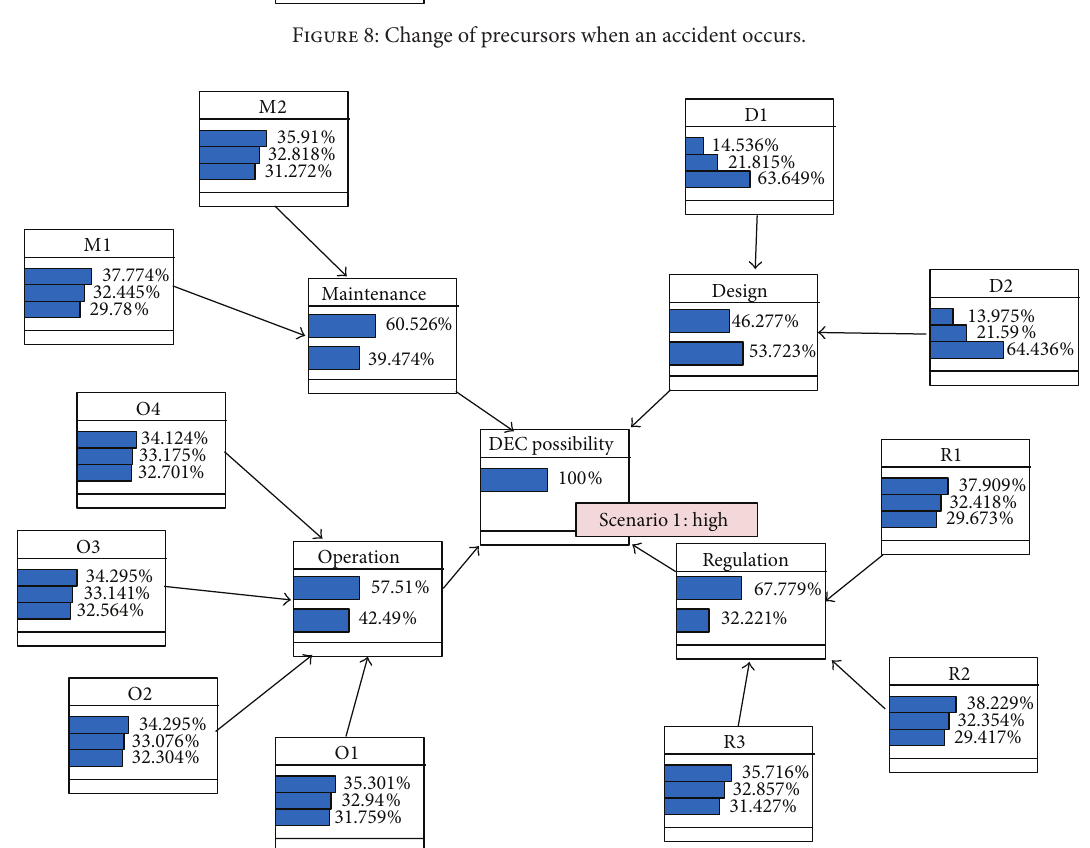
Figure 8: Change of precursors when an accident occurs.